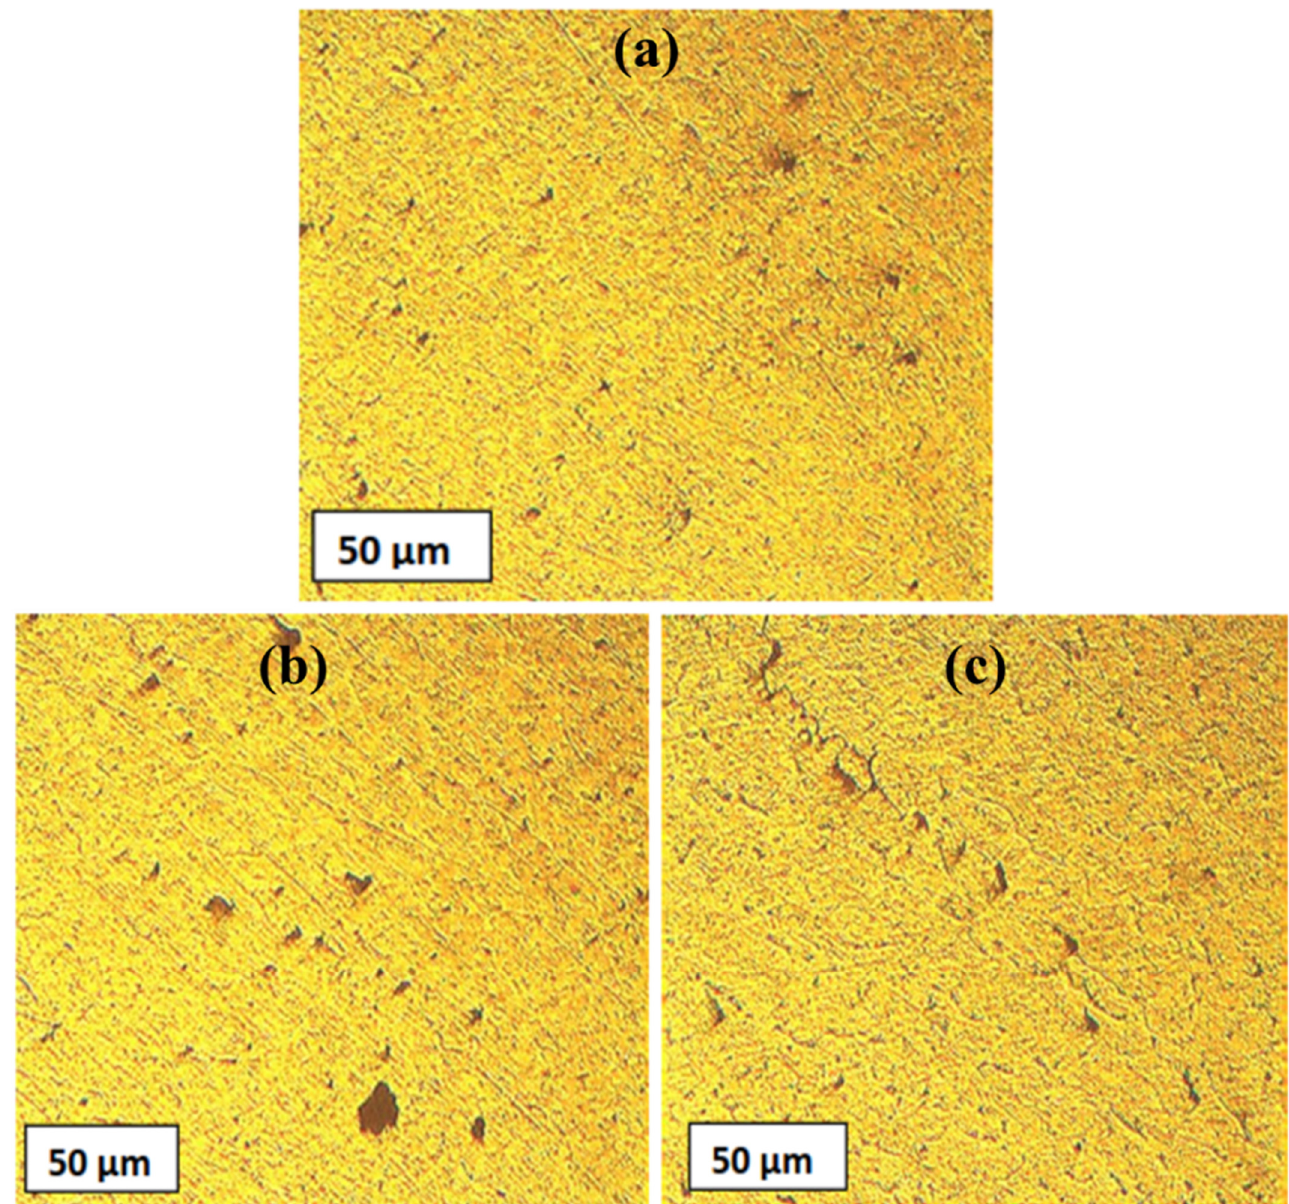
Figure 11. Distinct microstructures of Al-MMC: ( a ) base metal, ( b ) stir zone, ( c ) thermomechanical affected zone/stir zone. The microstructural examination at the joints reveals the flow of plasticized metal from advancing to the retreating side. The dynamic recrystallized zones of samples ob- tained from the FSW are shown in Figure 12a,b. It was observed that the reinforcement particles were distributed uniformly, and no undesired higher order reactions in the dy- namic recrystallized zones were seen. It is in coherence with other reports [24–26]. The formation of onion rings was observed from Figure 12b due to the composite’s cylindrical FSW rotating tool material extrusion. There were no traces of common defects to FSW processes such as tunnels, wormholes and piping due to B 4 C dislocation in the Al matrix. The extensive stirring action of FSW resulted in the formation of homogenous and refined grains at the weld zone.